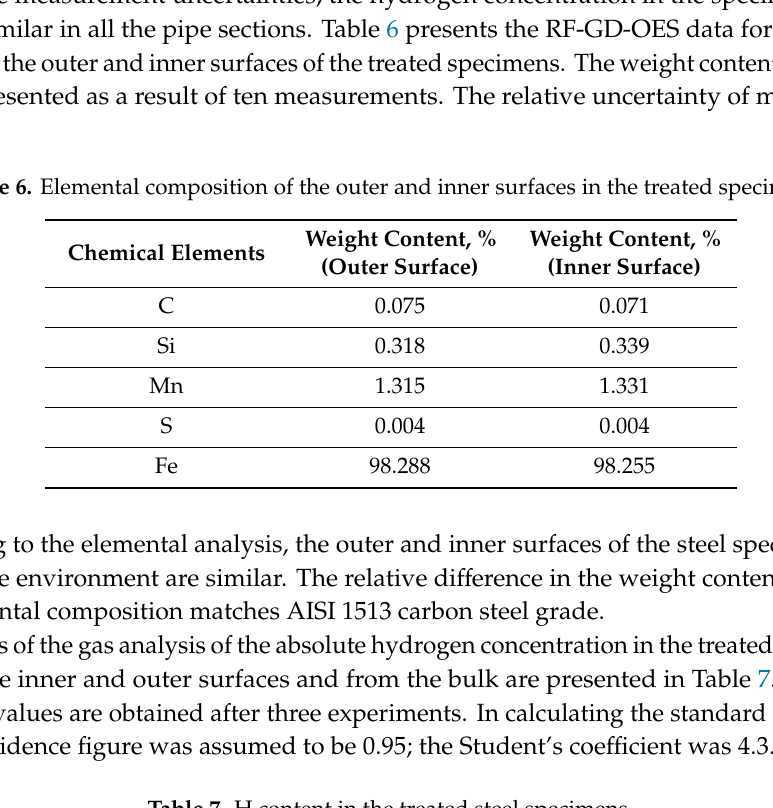
Table 7. H content in the treated steel